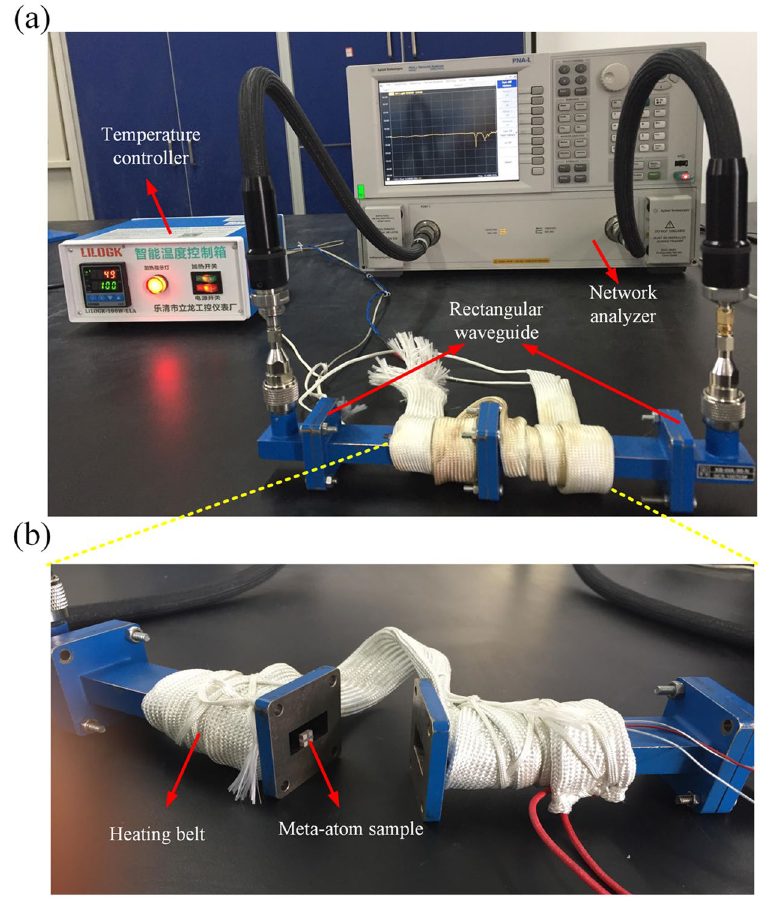
Figure 4. ( a ) The measurement setup. ( b ) The sample placed in the